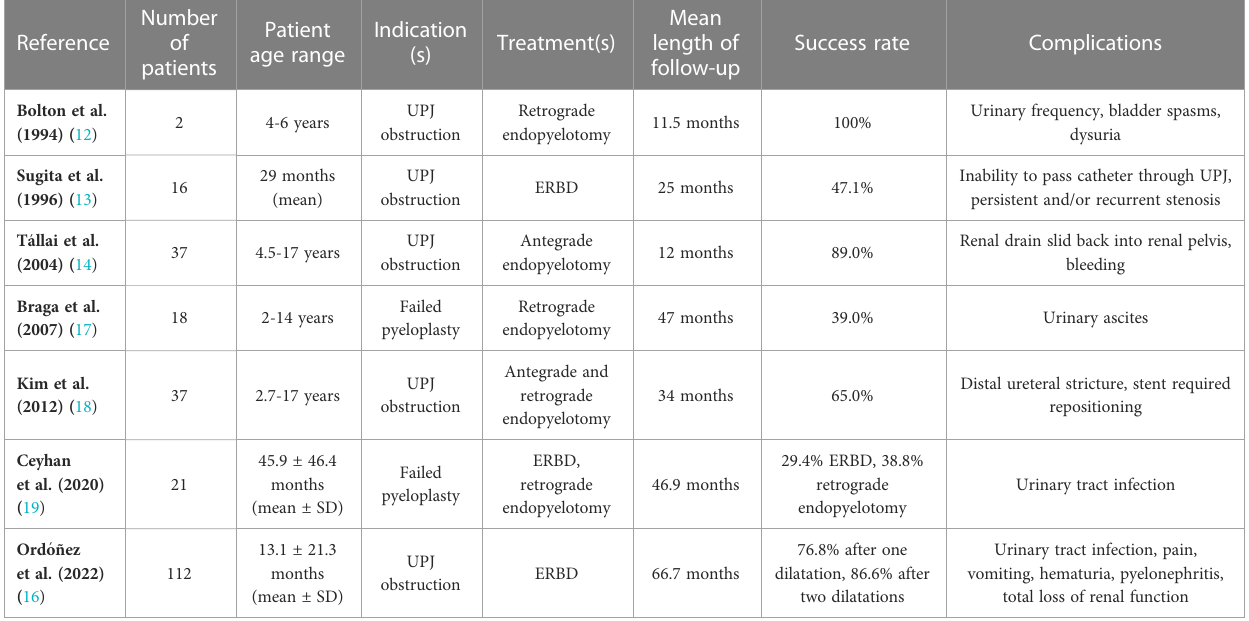
TABLE 1 Summary of outcomes of endoscopic management of ureteropelvic junction (UPJ) obstruction.